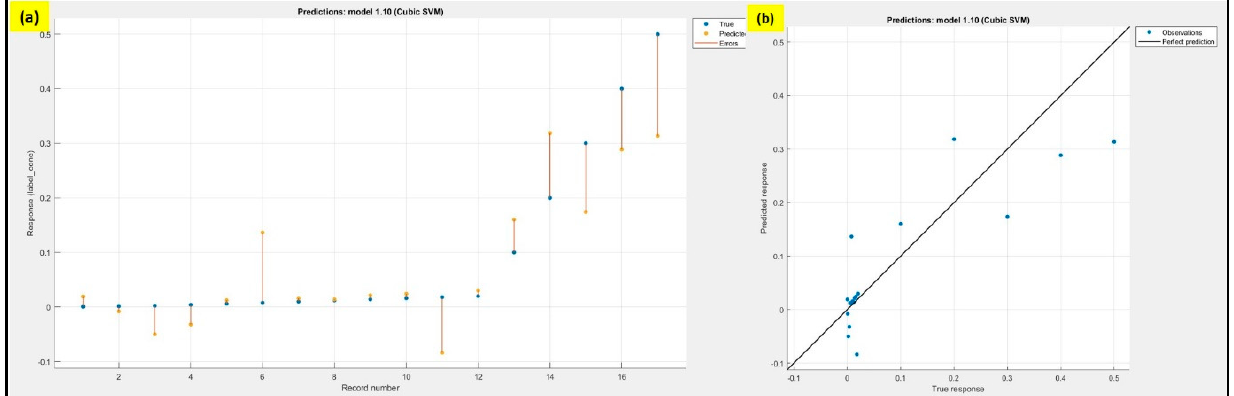
Figure 13. ( a ) Errors in prediction with respect to the actual data, ( b ) the predicted vs. actual